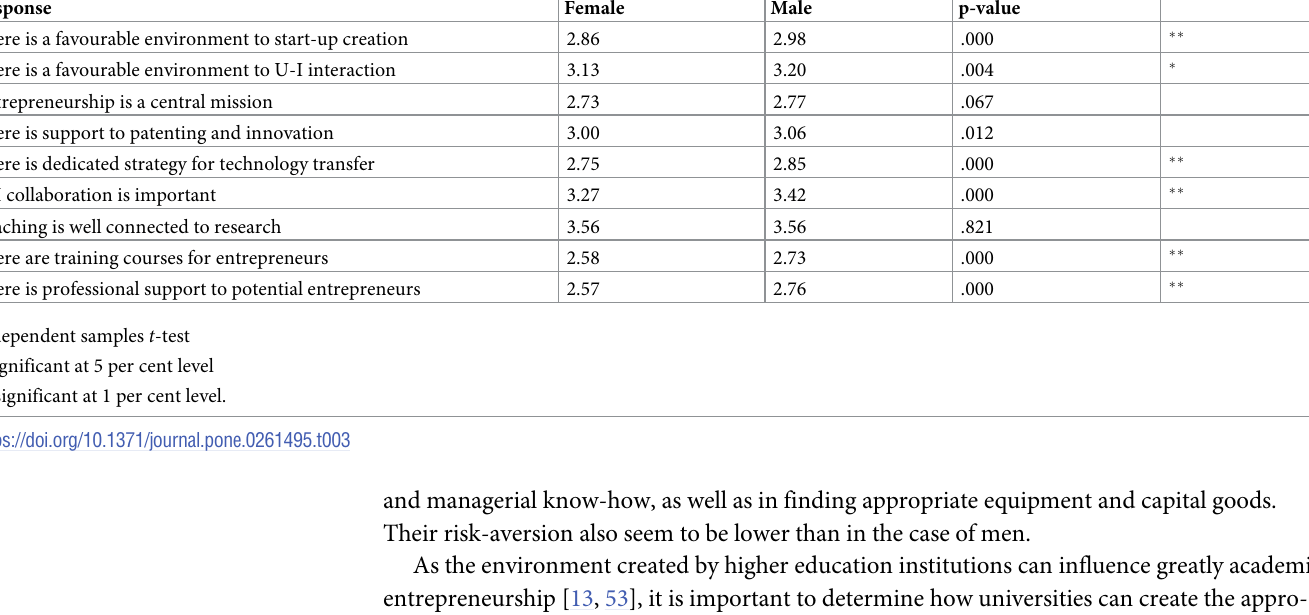
Table 3. Students’ opinion about the entrepreneurship environment at the parent university.